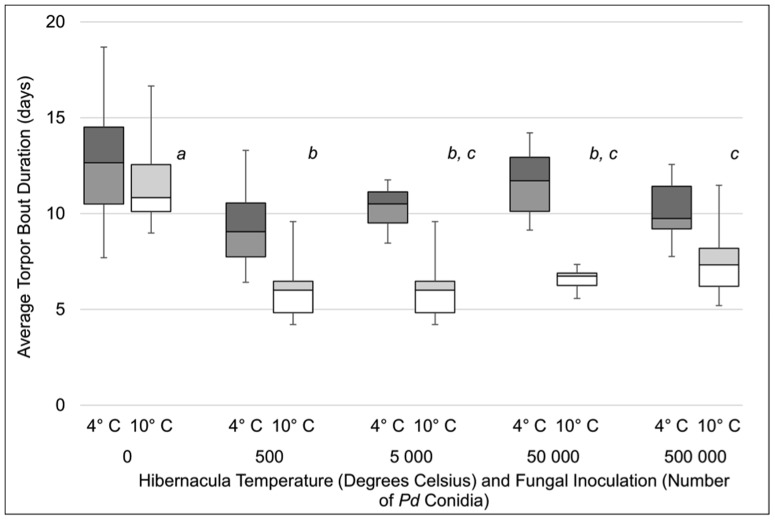
Average duration of torpor bouts (days) for little brown myotis (Myotis lucifugus) inoculated with different doses of Pseudogymnoascus destructans (Pd) conidia and hibernated for five months at either 4 or 10°C.Within each temperature, treatments not sharing common superscript letters were significantly different (P<0.05). All doses differed between temperatures (P<0.05).